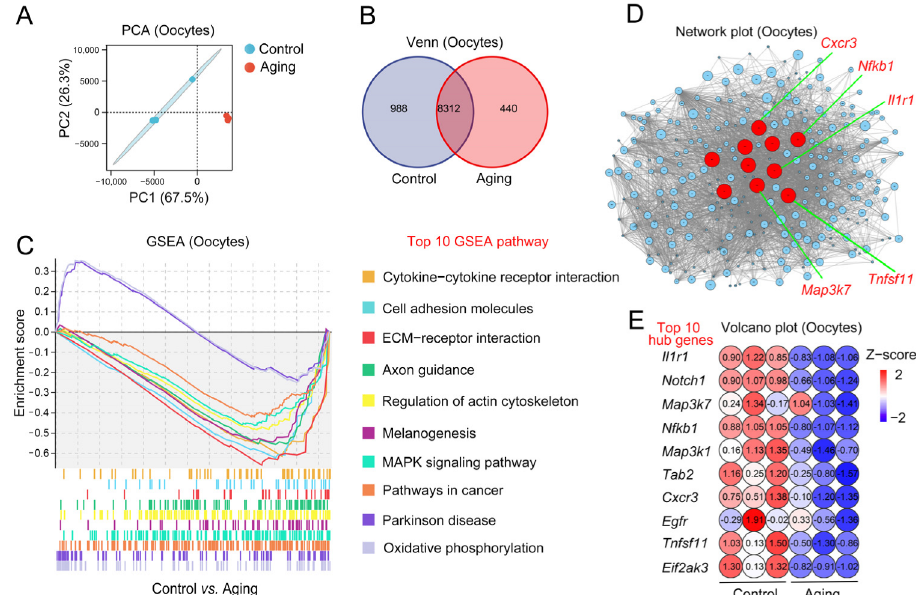
Figure 3. Changes to aging-related transcription levels in oocytes. ( A ) PCA diagram of oocytes’ Smart-seq 2. The blue circle stands for the control oocytes; the red circle stands for the aging oocytes. ( B ) Venn diagram of genes expressed in control oocytes and aging oocytes. ( C ) Representative diagram of top 10 aging-related GSEA pathways in control and aging oocytes. ( D ) Network plot exhibiting aging-related essential genes in oocytes. Each circle represents one individual gene; red circles indicate the top 10 hub genes. ( E ) Volcano plot showing the expression level of the top 10 aging-related hub genes in